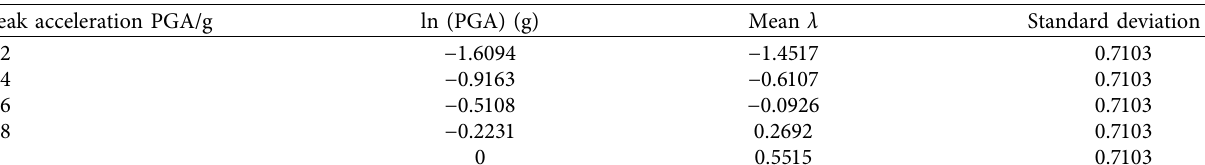
Table 4: Mean and standard deviation of capacity-demand ratio of the pier bottom section.